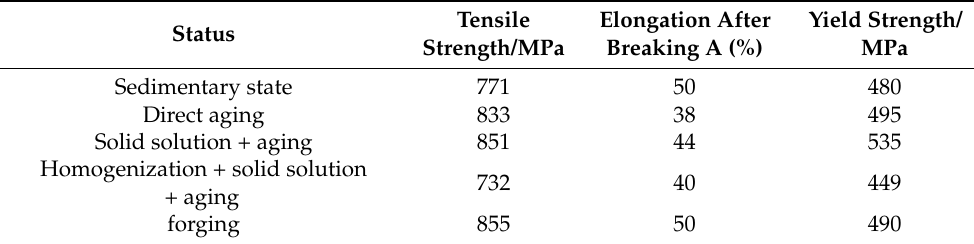
Table 3. Mechanical properties of materials before and after heat treatment [73].